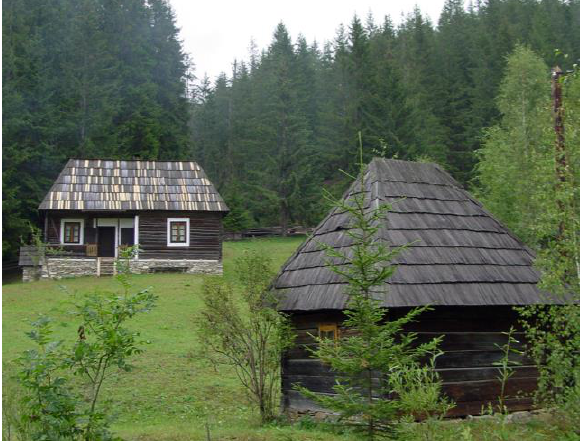
Figure 4. Restored and refurbished house, 19th